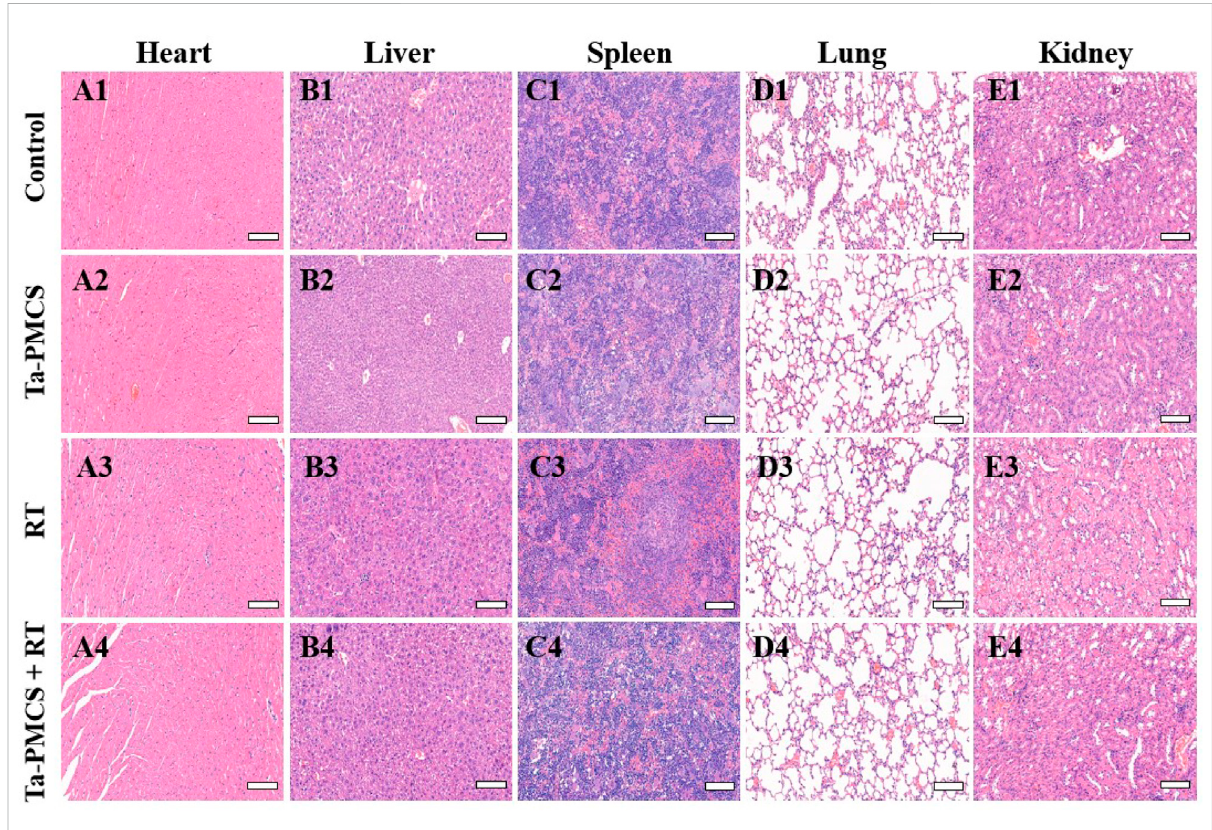
HE staining of major organs in mice injected with different treatments (scale bar: 50 μ